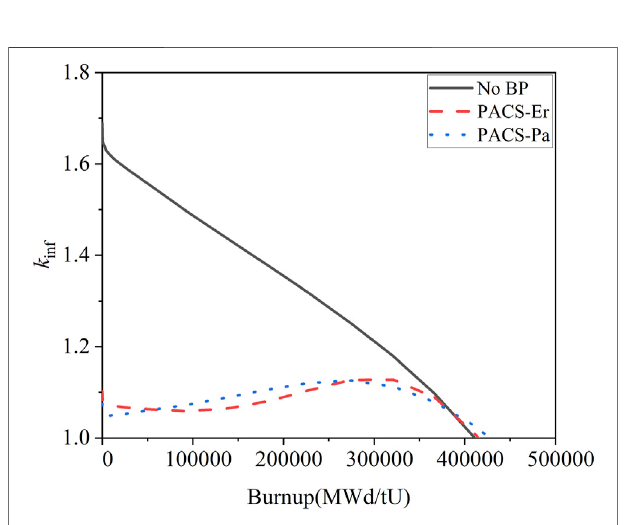
FIGURE 7 | Variation in the k inf of assembly with different BP combination